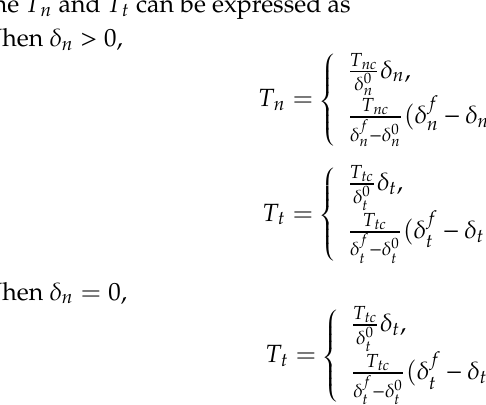
Figure 2. Bilinear traction–separation law for the cohesive zone model; ( a ) normal direction (mode I) and ( b ) tangential direction (mode II).